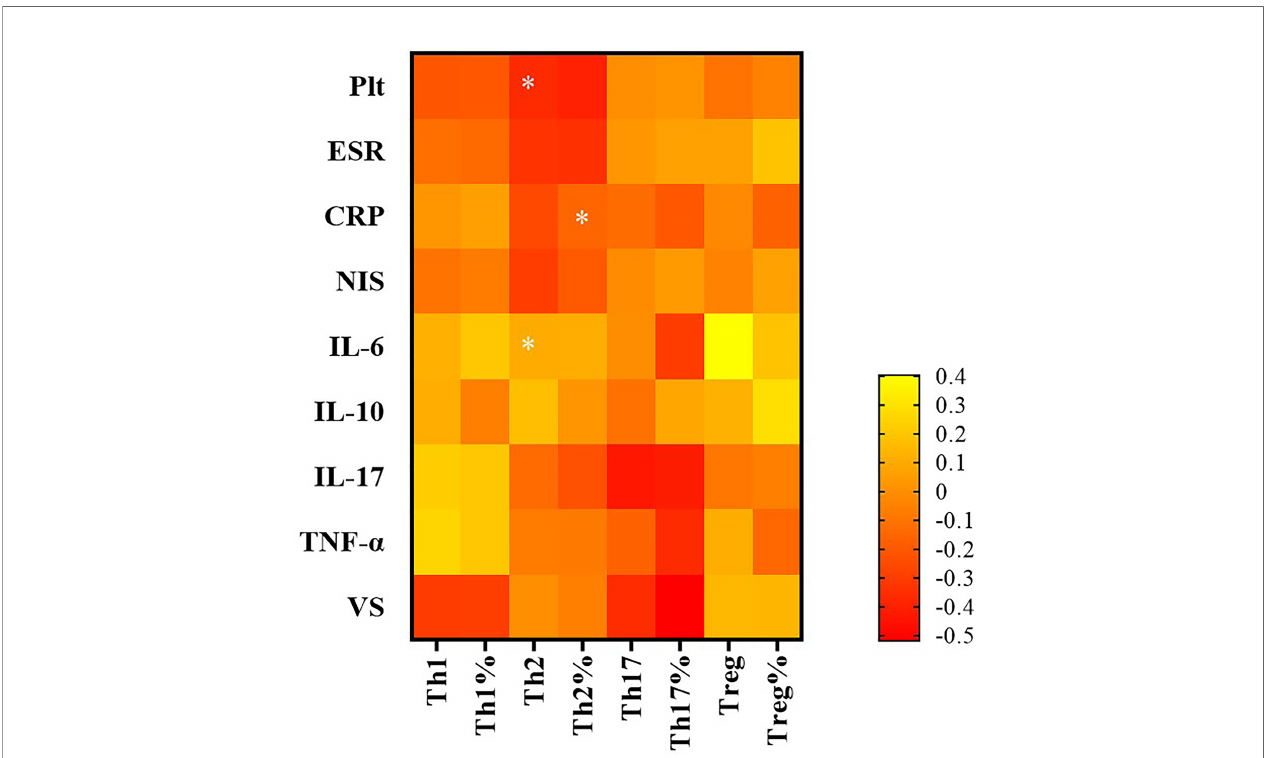
FIGURE 5 | The correlation between CD4 + T subsets and clinical indicators by Spearman correlation test. In TA patients, that of Th2 cells was negatively associated with platelet (PLT) and NIS score; the proportion of Th2 cells was negatively associated with erythrocyte sedimentation rate (ESR). *P < 0.05; P < 0.05 was considered statistically signi fi